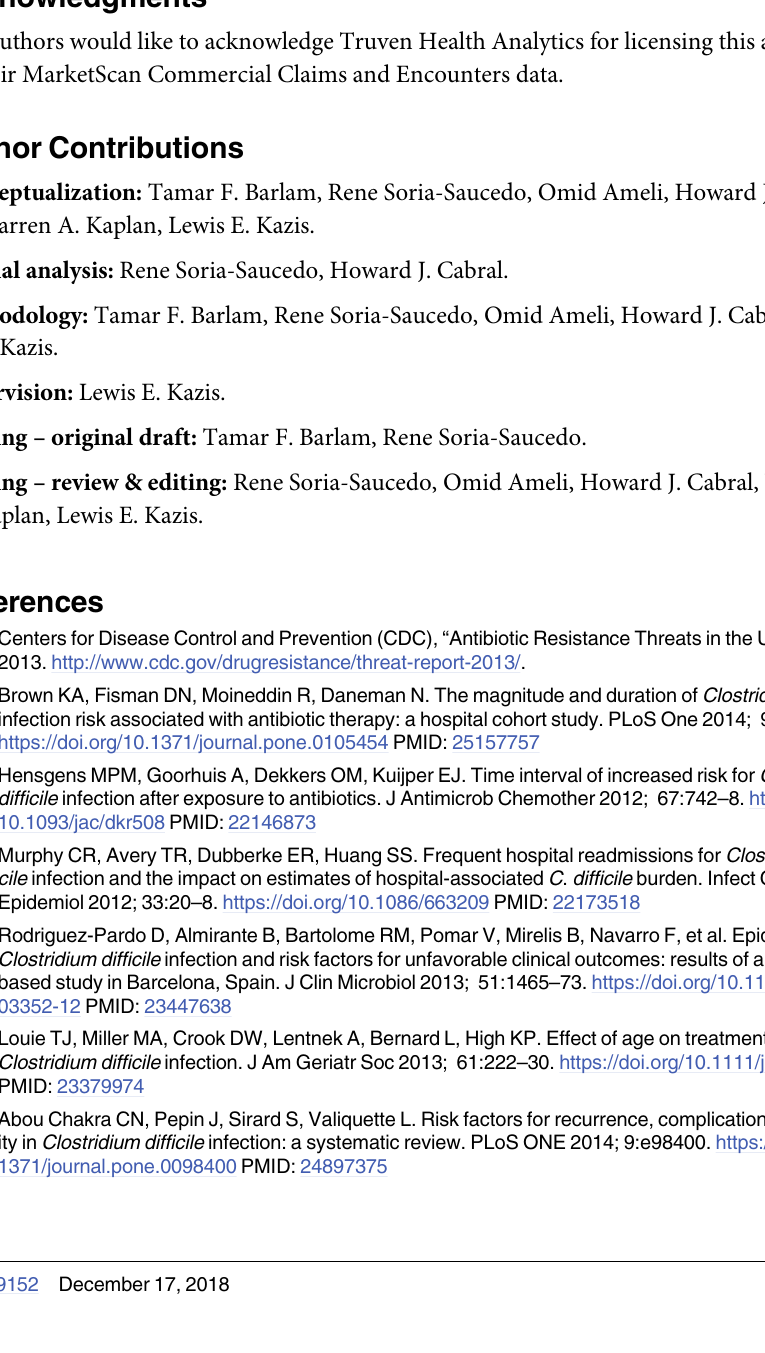
S2 Table. Unadjusted rate per 10,000 person-years for gastrointestinal diagnoses before and after first Clostridium difficile diagnosis. S3 Table. Prevalence of gastrointestinal (GI) diagnoses and Clostridium difficile diagnosis per person-admission at baseline and